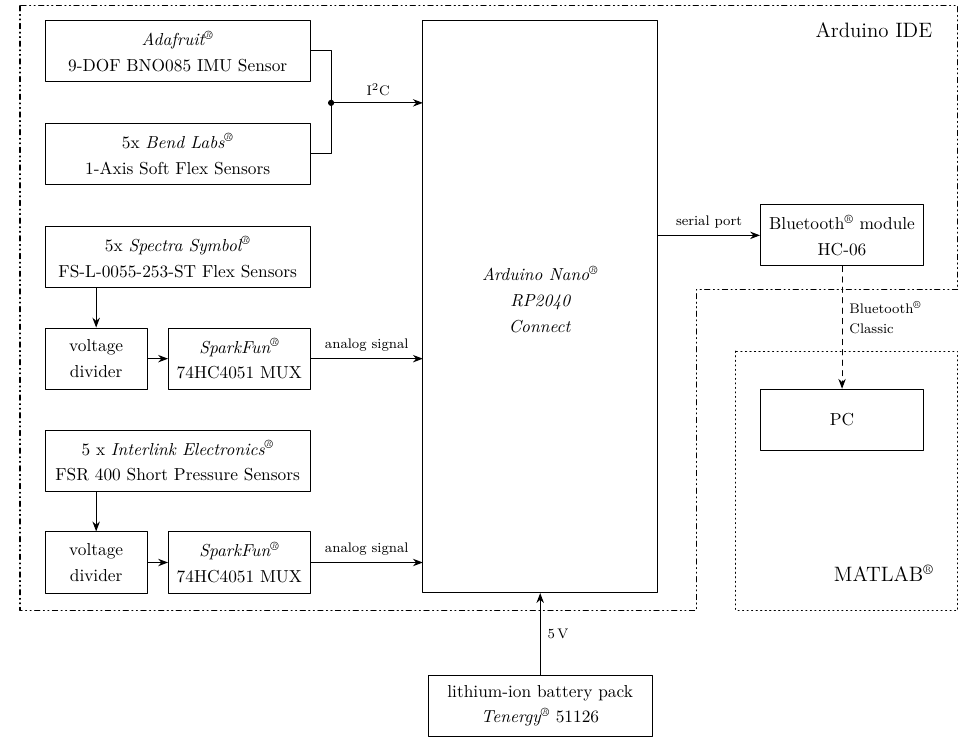
Figure 9. Electronic components and signal structure of